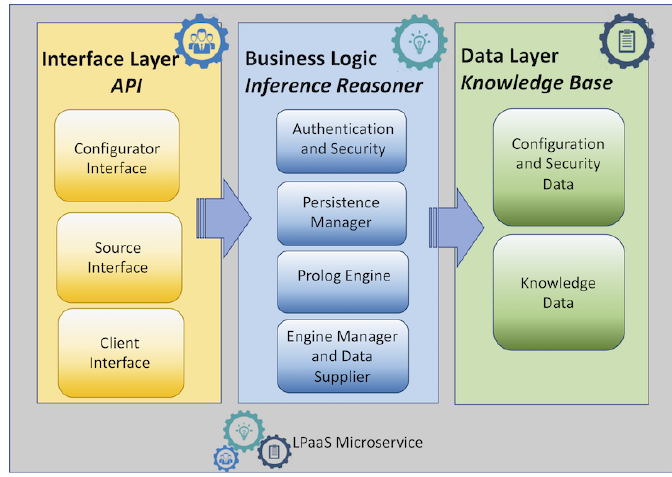
Figure 3. The LPaaS